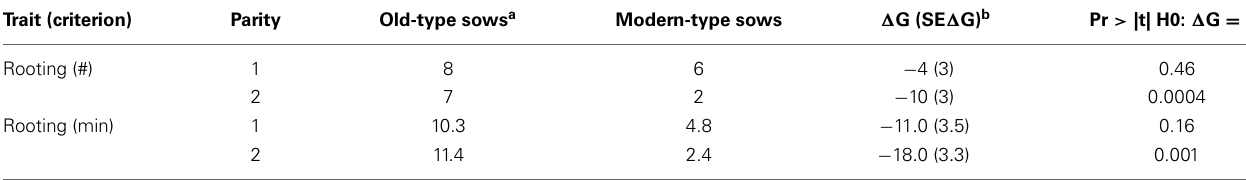
Table 4 | Genetic trends for sow exploratory